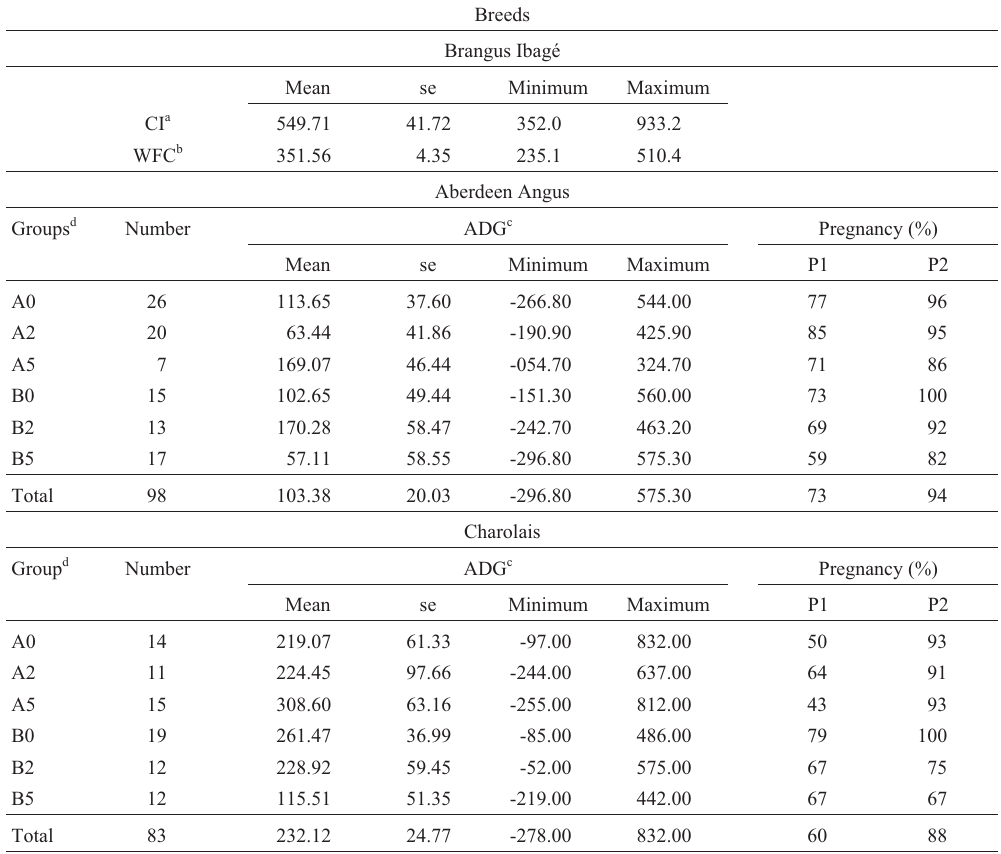
Table 3 - Descriptive statistics for CI and WFC in Brangus Ibagé, for ADG, P1 and P2 in Aberdeen Angus and Charolais populations, in relation to hor- mone treatment and nutrition groups.